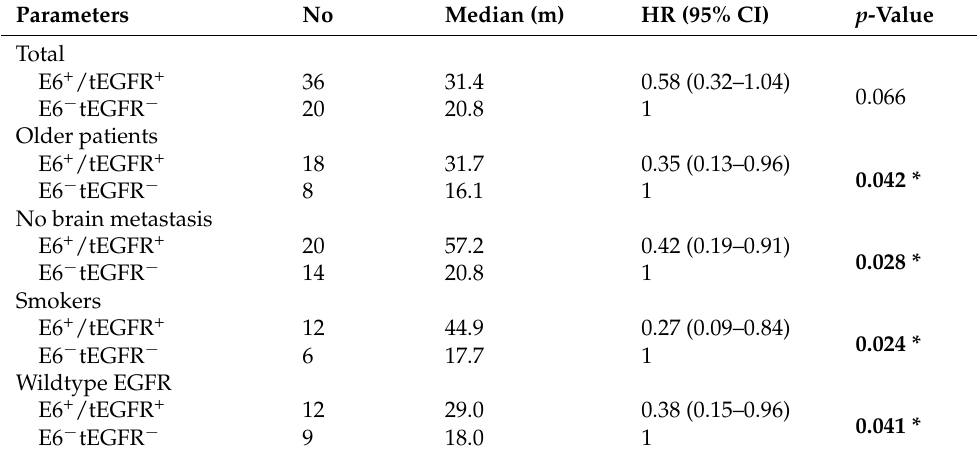
Table 3. Comparison of treatment response in 173 lung adenocarcinoma patients after platinum-based